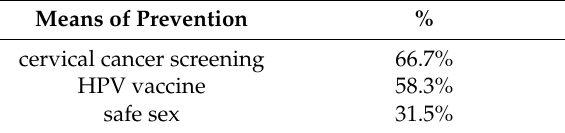
Table 4. Distribution of answers considering the means of cervical cancer prevention.